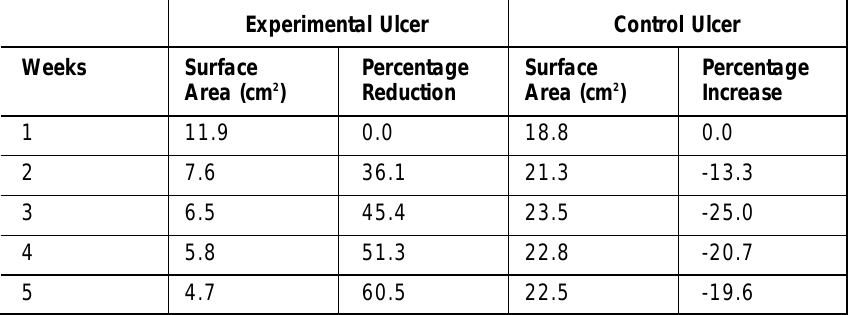
Table 1: Percentage changes in surface areas of the experimental and control ulcers.